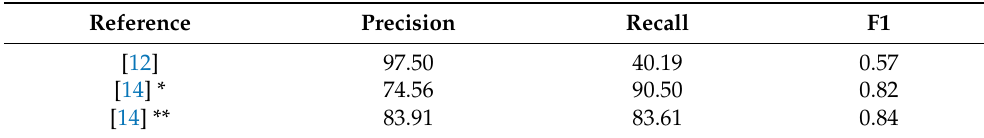
Table 5. Comparison of cited works using the WaDI data-set. * Indicates reported results based on recall. ** Indicates reported results based on F1 score.